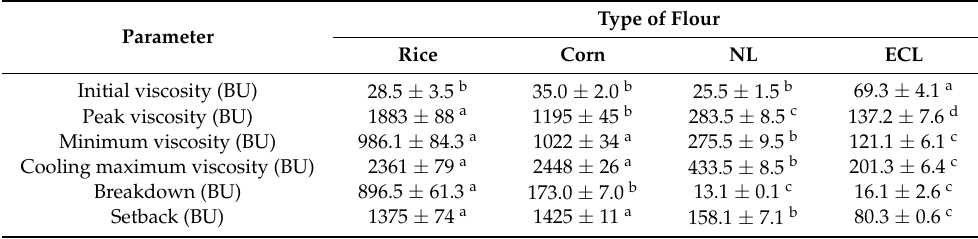
Table 3. Gelation properties (viscosity values, determined by a viscoamylograph), of the flours used for preparing the experimental GF pizza samples. NL = native lentil flour; ECL = extruded-cooked lentil